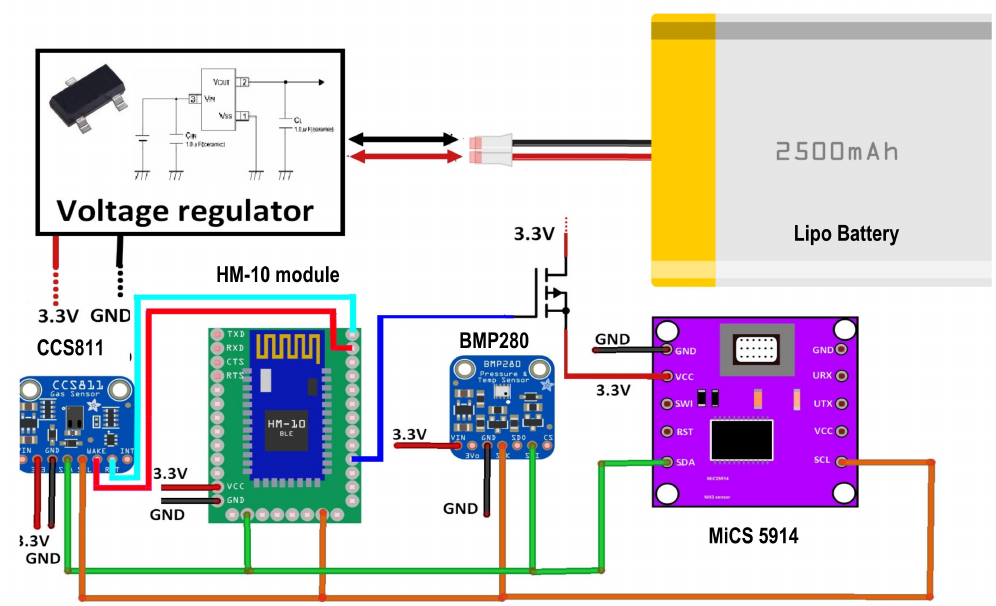
Figure 11. Schematic representation of the connections between the di ff erent components constituting the BLE smart